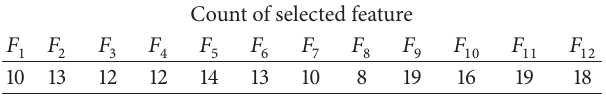
Figure 4: Flow chart of the proposed method. Table 5: Count of selected feature by using 5-fold